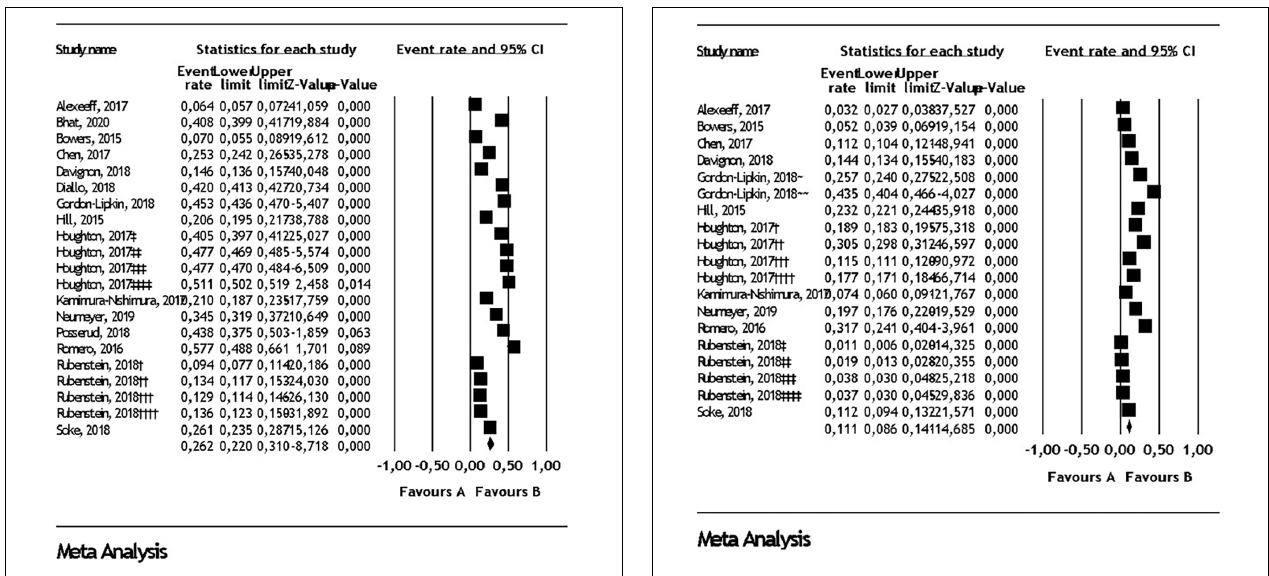
FIGURE 3 | Attention deficit/hyperactivity disorder comorbidity in autism spectrum disorder. Diamond represents the random effect model analysis result for the meta-analysis of 21 subgroups given in 15 studies ( † : 2002 ADDM data, †† : 2006 ADDM data, ††† : 2008 ADDM data, †††† : 2010 ADDM data, ‡ : 5-11 years old in commercial data, ‡‡ : 12-17 years old in commercial data, ‡‡‡ : 5-11 years old in Medicaid data, ‡‡‡‡ : 12-17 years old in Medicaid data).